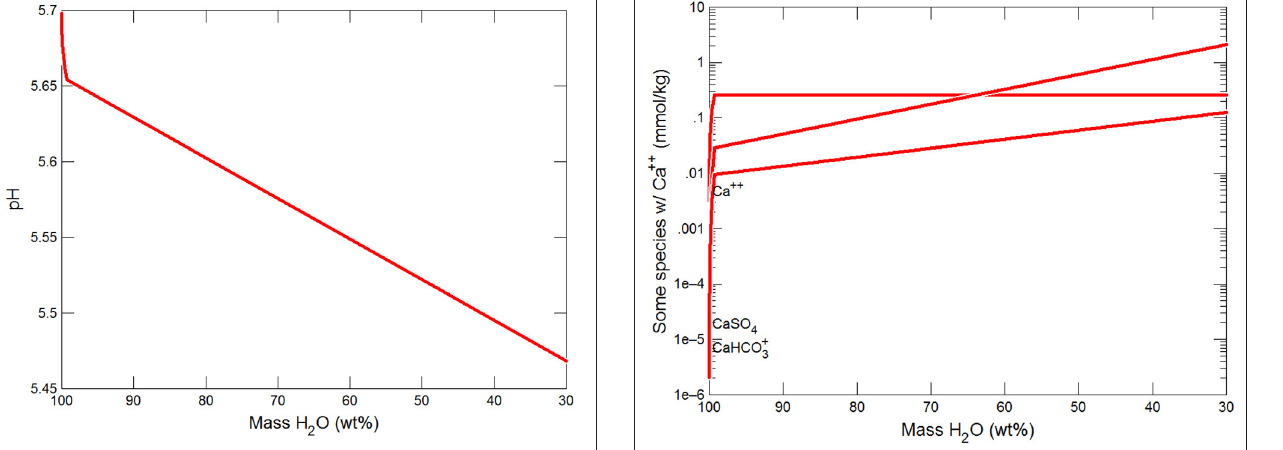
FIGURE 3 | Variations in pH during freezing of glacial water.